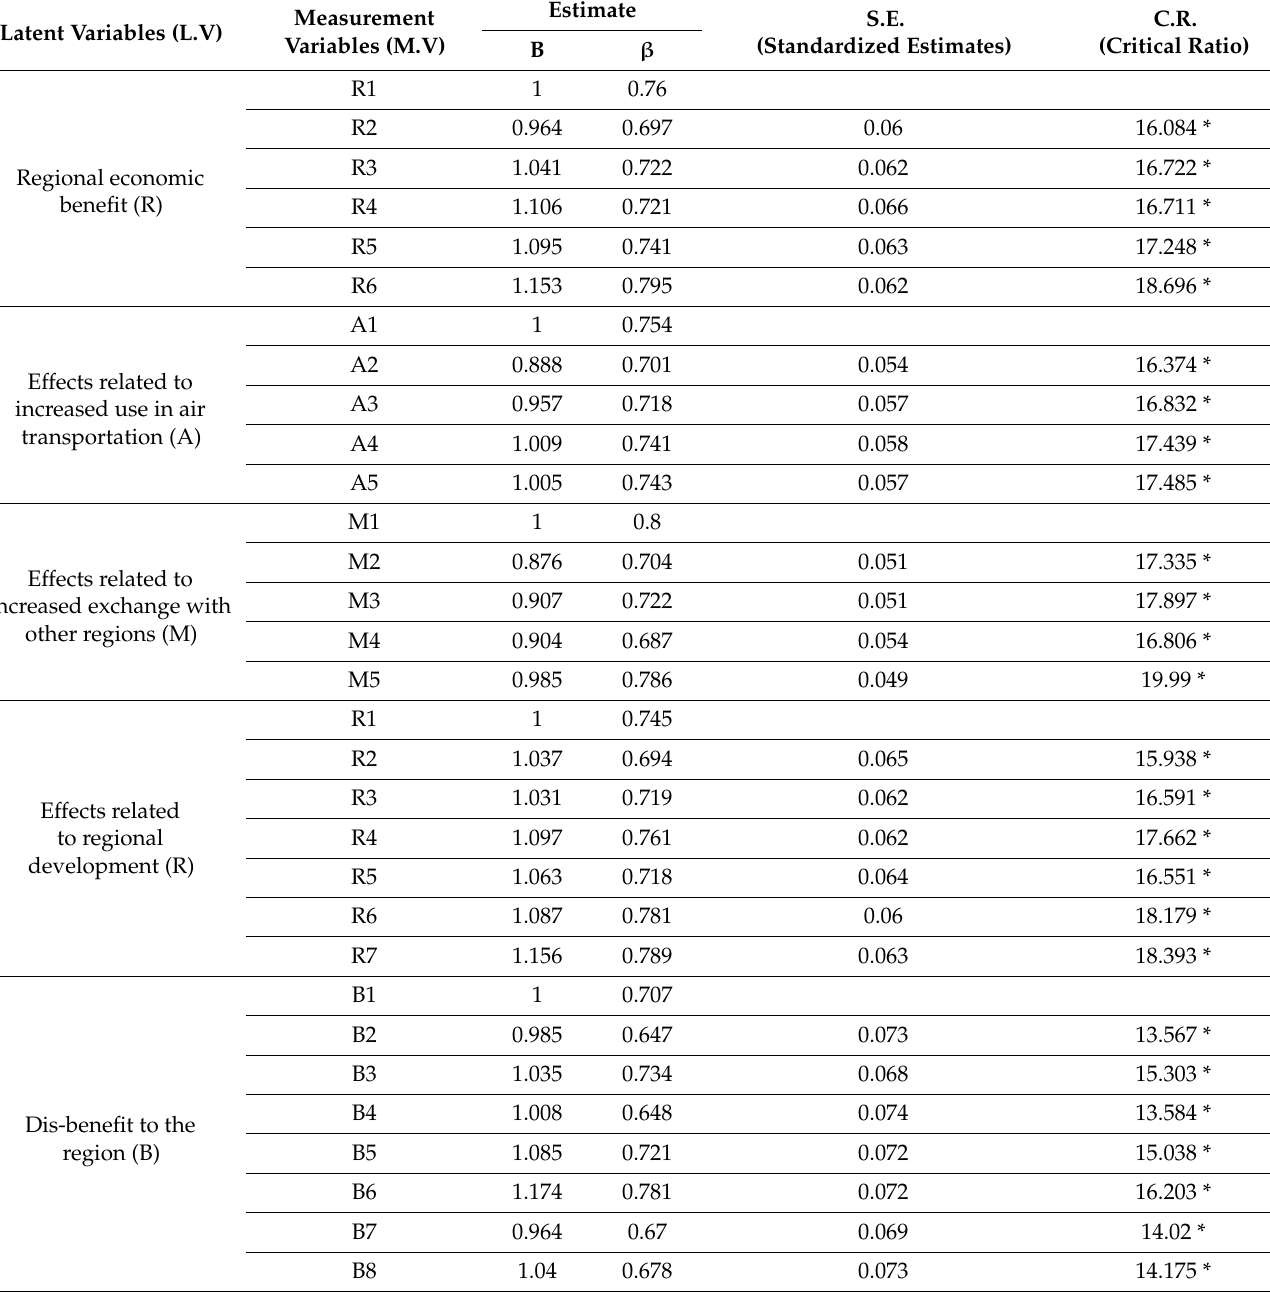
Table 3. Results of Confirmatory Factor